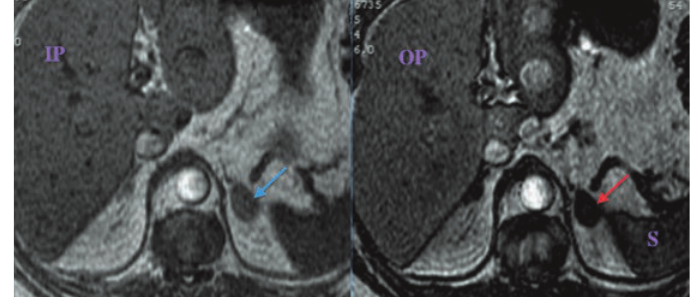
each pixel along the y -axis. The percentage of negative pixels of fat attenuation (values <0) is then calculated. Blake et al . [5] proposed that a threshold value >10% negative pixels is highly specific for adenomas.